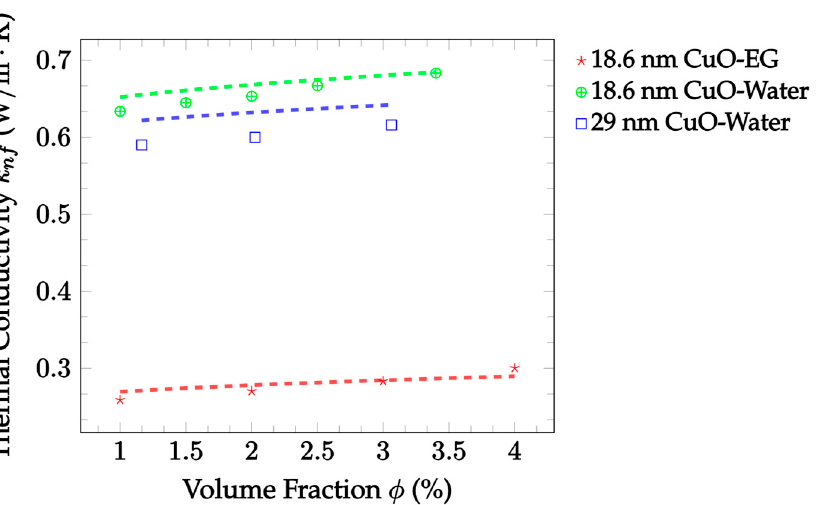
Figure 6. Patel et al. [23] model compared with experimental data for nanofluids with higher particle concentrations: 18.6 nm CuO–EG [12], 18.6 nm CuO-Water [12], 29 nm CuO–water [66]. Table 2. Level of accuracy (%) of each Brownian model when compared against given experimental data.